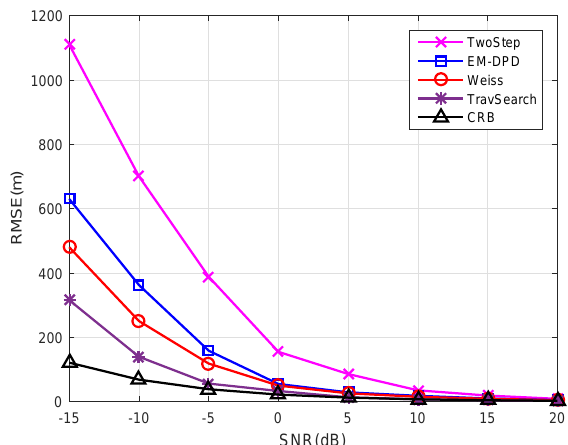
Figure 3. The RMSEs of different algorithms versus